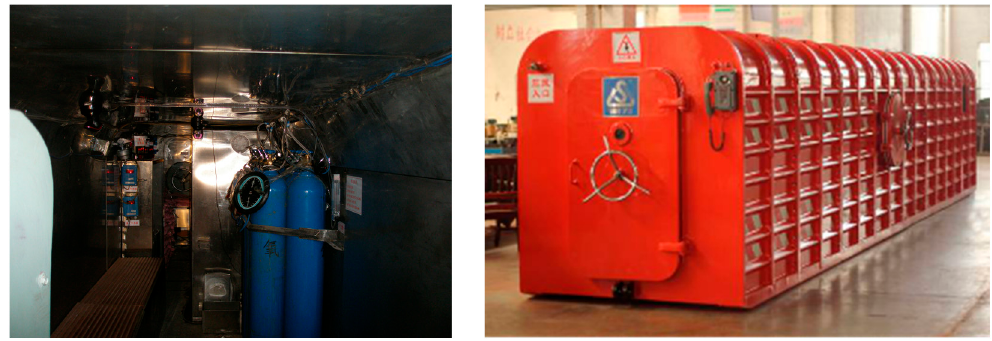
Figure 1. Photograph of a movable refuge chamber, inside ( left ) and outside ( right ).